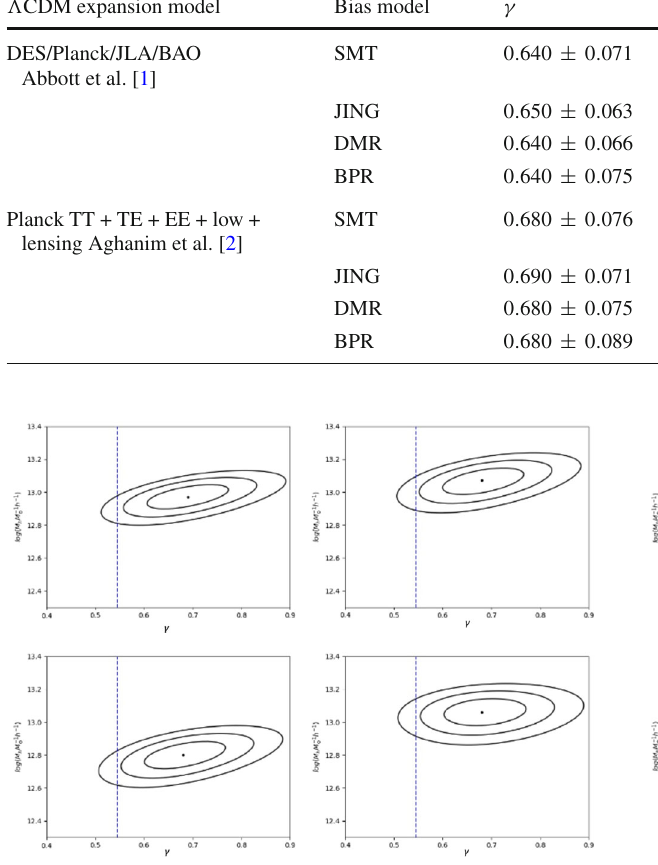
Fig. 1 The iso-likelihood contours for 1 σ —2 σ -3 σ levels in the (γ, M ) parameter space for different bias models. Upper row: From h left to right, JING and SMT models. Lower row: DMR and BPR mod- els. For further details regarding the models, please see the relevant section. Notice that we use the DES/Planck/JLA/BAO (cid:7) CDM cosmol- ogy [1]. The best fit values are given in Table 2. The vertical dashed line corresponds to γ GR ∼ 6 / 11